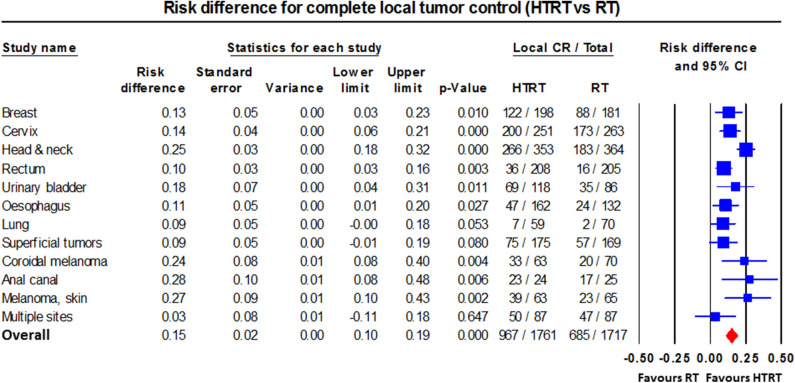
Forest plot showing the risk difference of complete local tumor control in patients from various disease sites treated with thermoradiotherapy (HTRT) vs. radiotherapy (RT) alone. Plot generated using data from Datta et al. (12).